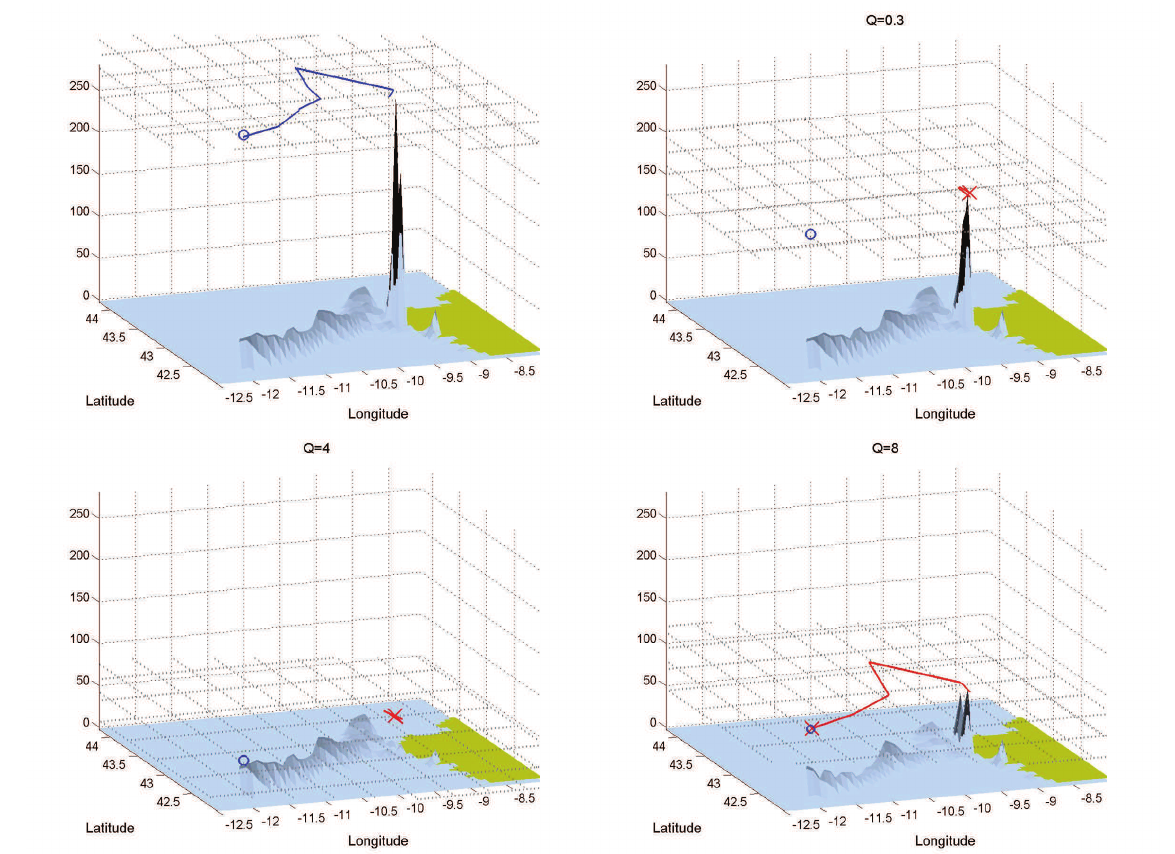
Fig. 6 3D view of the final oil concentration distribution on the 19th of November 2002 for the experiments: ( Top-Left ) case with no pumping process, ( Top-Right ) OPT-0.3- (3), ( Bottom-Left ) OPT-4- (3) and ( Bottom Right ) OPT-8- (3). A plane at the same height as the maximum value of the oil concentration is also presented. In this plane the skimmer ship trajectory (continuous red line), the Prestige ship trajectory when there is no pumping process (continuous blue line), final position of the skimmer ship (x) and final position of the Prestige ship (o) are